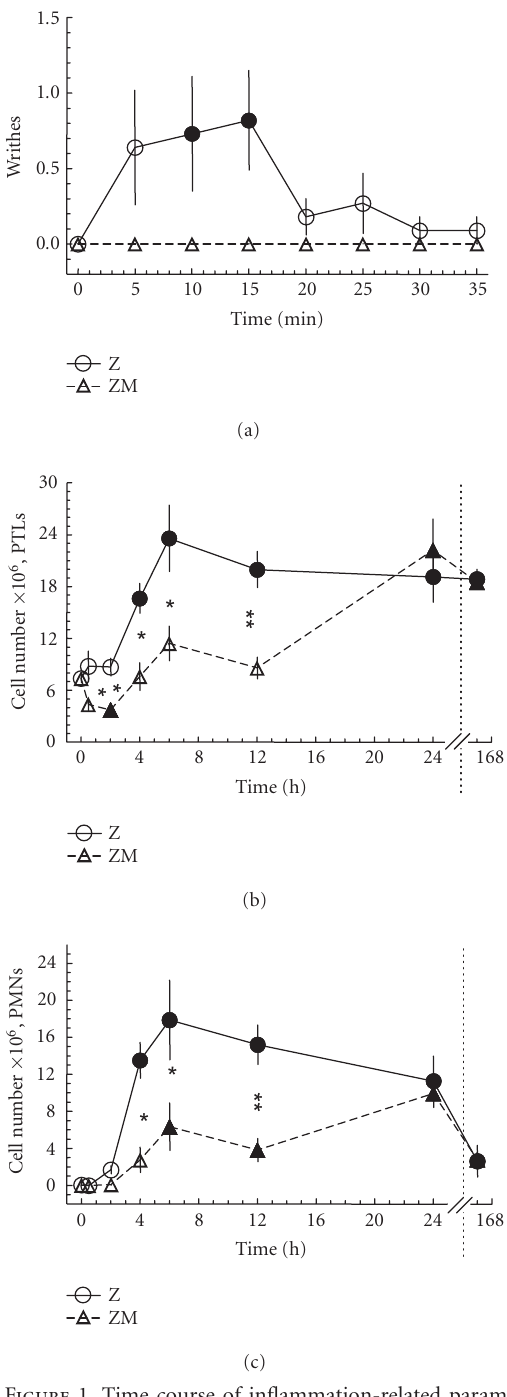
Figure 1. Time course of inflammation-related parameters in males of Swiss mice either intact (time 0) or IP injected with zymosan (Z, solid lines and circles) or zymosan with morphine (ZM, broken lines and triangles). (a) Number of body writhes; peritoneal cell numbers; (b) total peritoneal leukocytes (PTLs); (c) polimorphonuclear leukocytes (PMNs). The results are ex- pressed as X+SE, n = 4–8. Solid symbols indicate means signif- icantly di ff erent from time 0 according to ANOVA at P < . 05; asterisks between significantly di ff erent means of Z and ZM groups at the given time point according to post hoc Tukey’s test denote that P < . 05 ( ∗ ), P < . 01 ( ∗∗